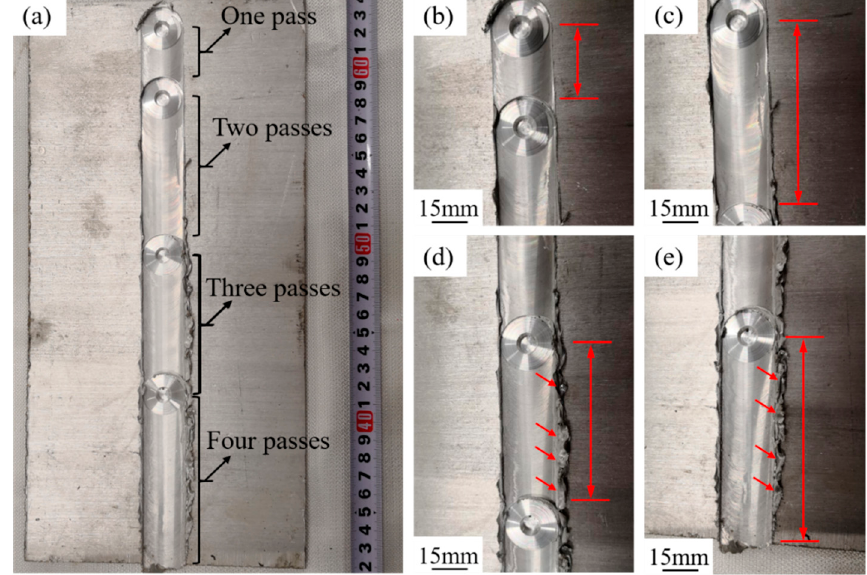
Figure 2. 1060Al/Q235 composite plate after multi-pass friction stir processing (M-FSP) with different passes: ( a ) 1060Al/Q235 composite plate after M-FSP; ( b ) single pass; ( c ) two passes; ( d ) three passes; ( e ) four passes.